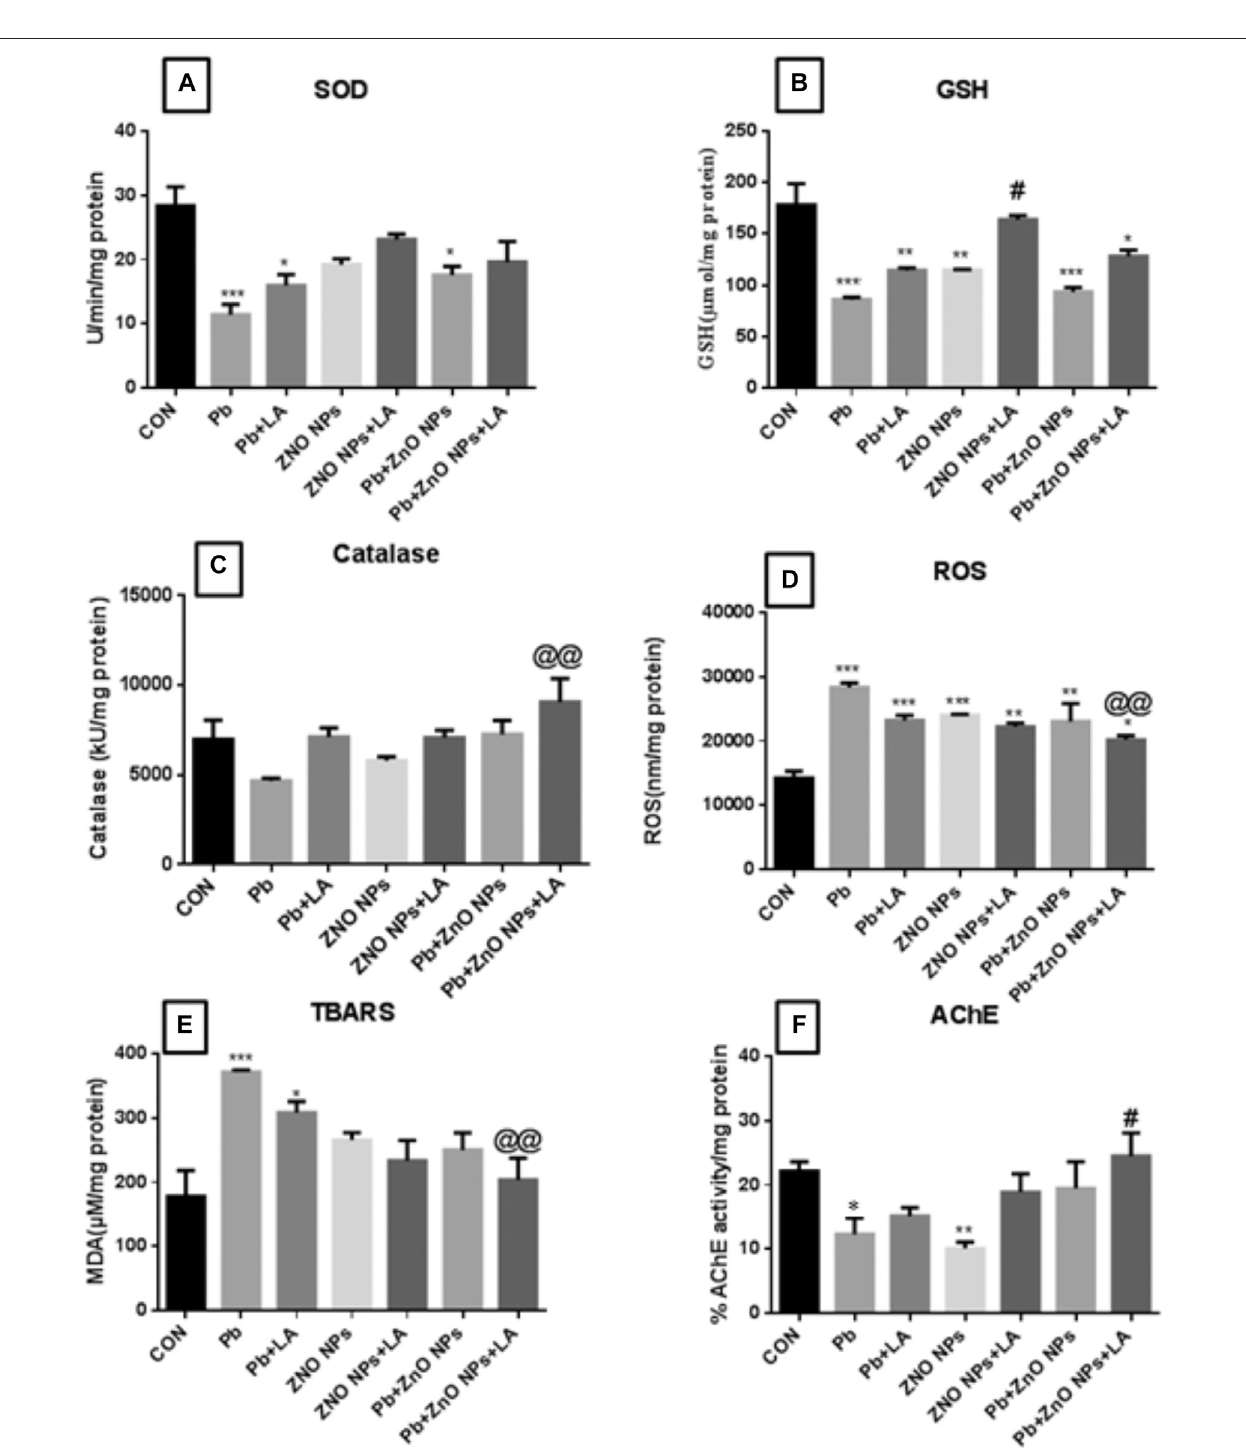
FIGURE6 | Brain biochemical parameters and AChEactivity. (A) SOD activity; (B) GSH activity; (C) catalase activity; (D) ROSlevel; (E) TBARSlevel;and (F) AChE activity.Allthevaluesareexpressedasmean ± SEM(n (cid:2) 4).Thestatisticalsigni fi cancewasconsideredat p < 0.05,andstatisticalanalysiswasperformedusingone-way ANOVA, followed by Tukey ’ s test. * p < 0.05, ** p < 0.01, *** p < 0.001 vs. Control; @@ p < 0.01 vs. lead; # p < 0.05, ## p < 0.01 vs. ZnO NPs. SOD: superoxide dismutase; GSH: glutathione; ROS: reactive oxygen species; TBARS: thiobarbituric acid reactive substances; AChE: acetylcholinesterase; SEM: standard error of mean; and ANOVA: analysis of